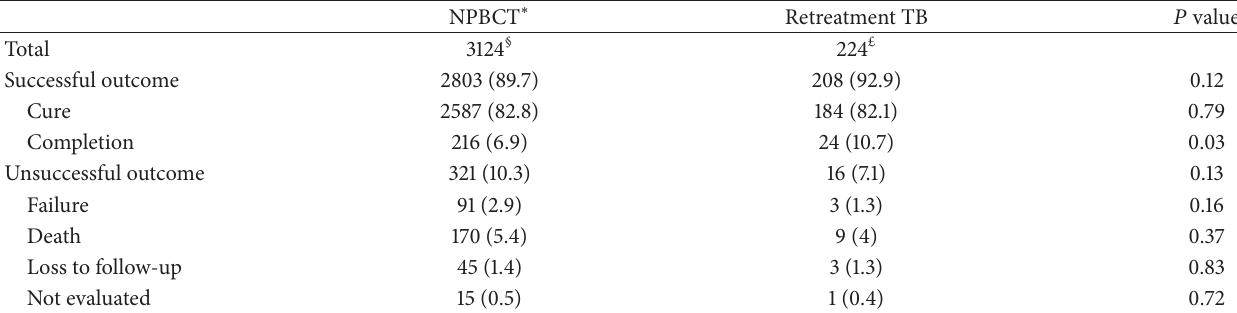
Table 5: Treatment outcomes of new pulmonary bacteriologically confirmed and retreatment tuberculosis patients, Benin,